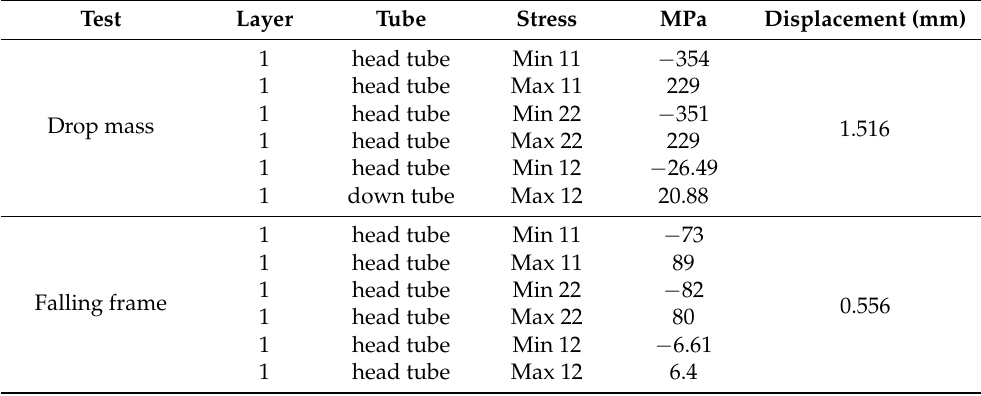
Table 17. Stress and displacement results of M46J Woven quasi-isotropic